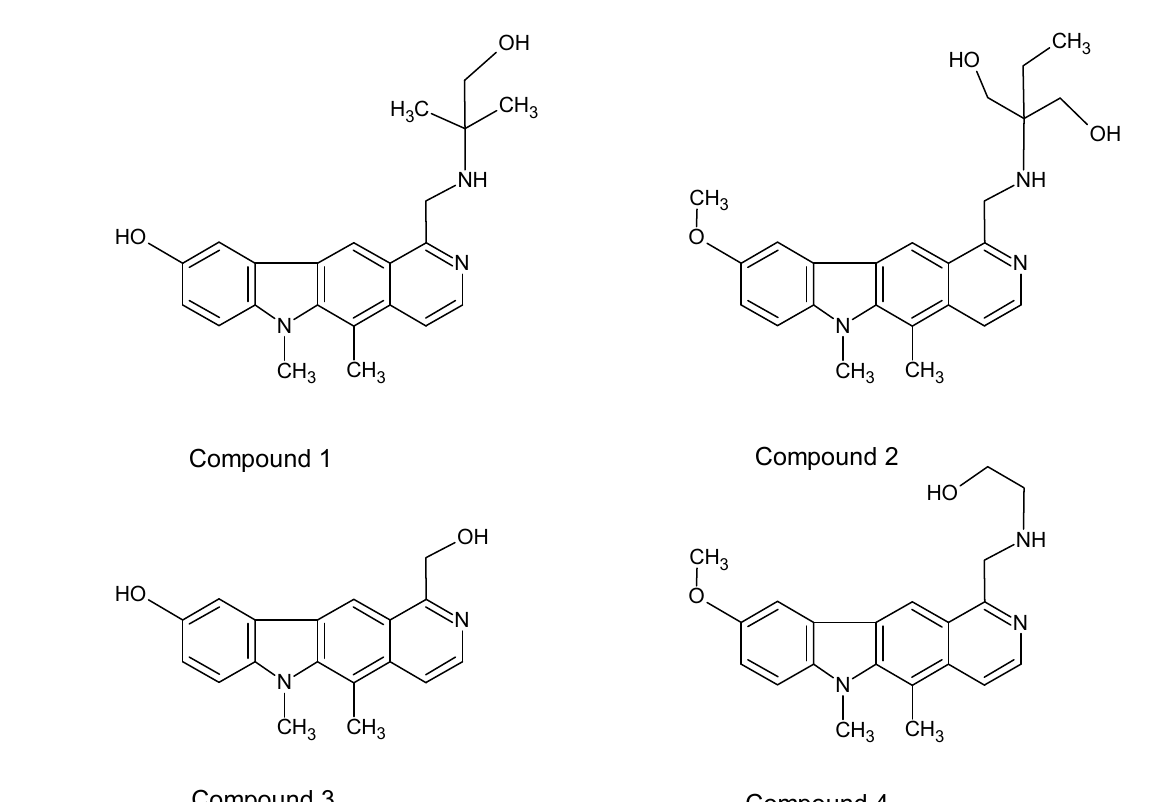
Figure 2. Derivatives of olivacine investigated in this study. Compound 1: 9-hydroxy-5,6-dimethyl-1-{[(1-hydroxy-2-methylpropan-2-yl)amino]methyl}-6 H -pyrido[4,3- b ]carbazole; Compound 2: 9-methoxy-5,6-dimethyl-1-({[1-hydroxy-2-(hydroxymethyl)butan-2-yl]amino} methyl)-6 H -pyrido[4,3- b ]carbazole; Compound 3: 9-hydroxy-5,6-dimethyl-1-hydroxymethyl-6 H -pyrido[4,3- b ]carbazole; Compound 4: 9-methoxy-5,6-dimethyl-1-{[(1-hydroxy-ethyl-2-yl)amino] methyl}-6 H -pyrido[4,3- b ]carbazole.